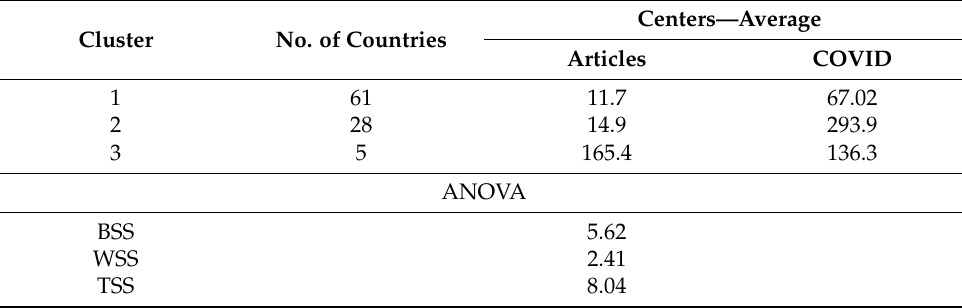
Figure 9. Cluster analysis—articles vs. COVID. Table 4. Cluster analysis diagnostics and features — articles vs. COVID.